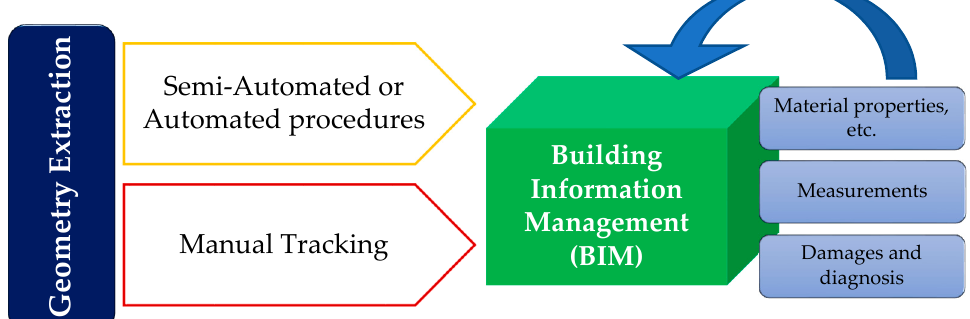
Figure 3. Modeling of a structure in a Building Information Model (BIM) environment and collection of disaggregated and heterogeneous information using manual or semi-automated techniques based on extracted geometries.